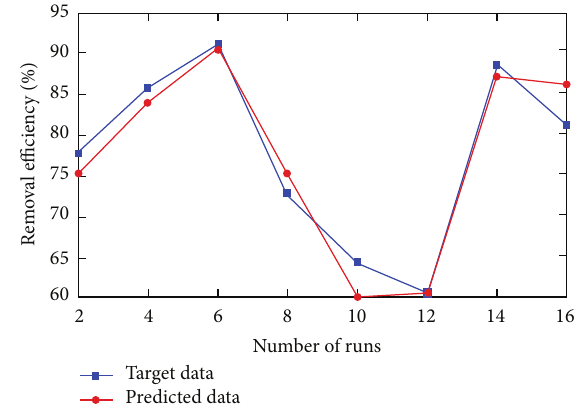
Figure 11: Testing procedure of the suggested CFNN.